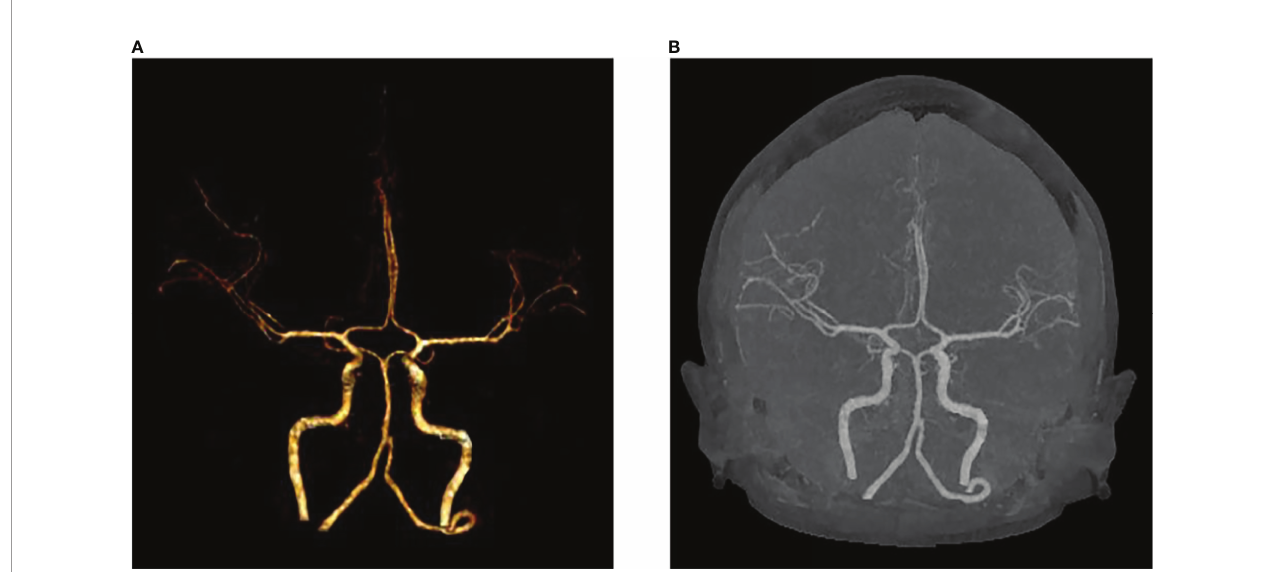
FIGURE 2 | No signi fi cant abnormalities in the intracranial arteries on VRT (A) and MIP (B) .